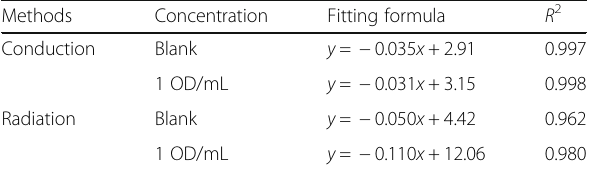
Table 1 The results of ambient temperature